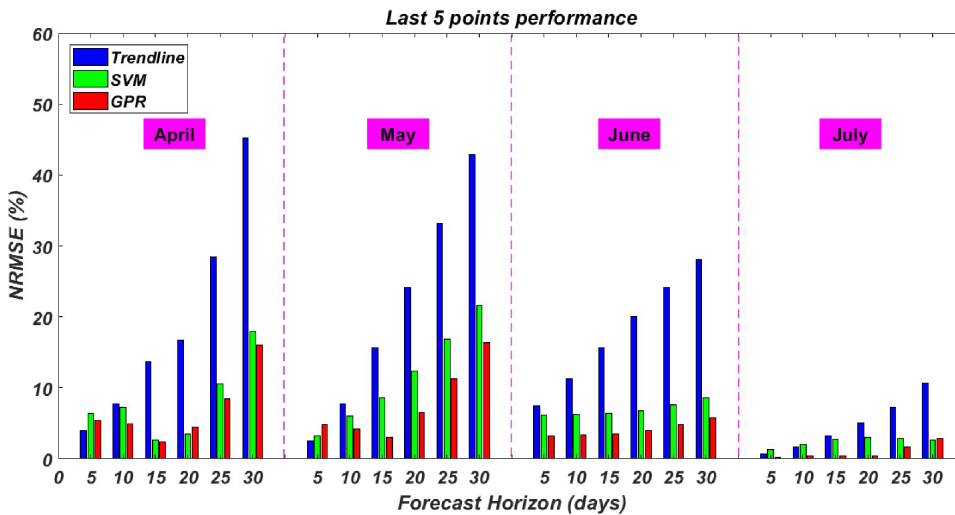
Fig 3. Models performance measured over the last 5 points of the